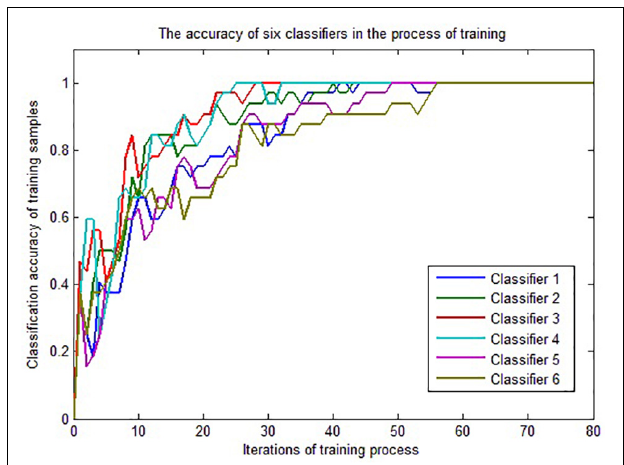
FIGURE 5 | The classification accuracy changed in the process of